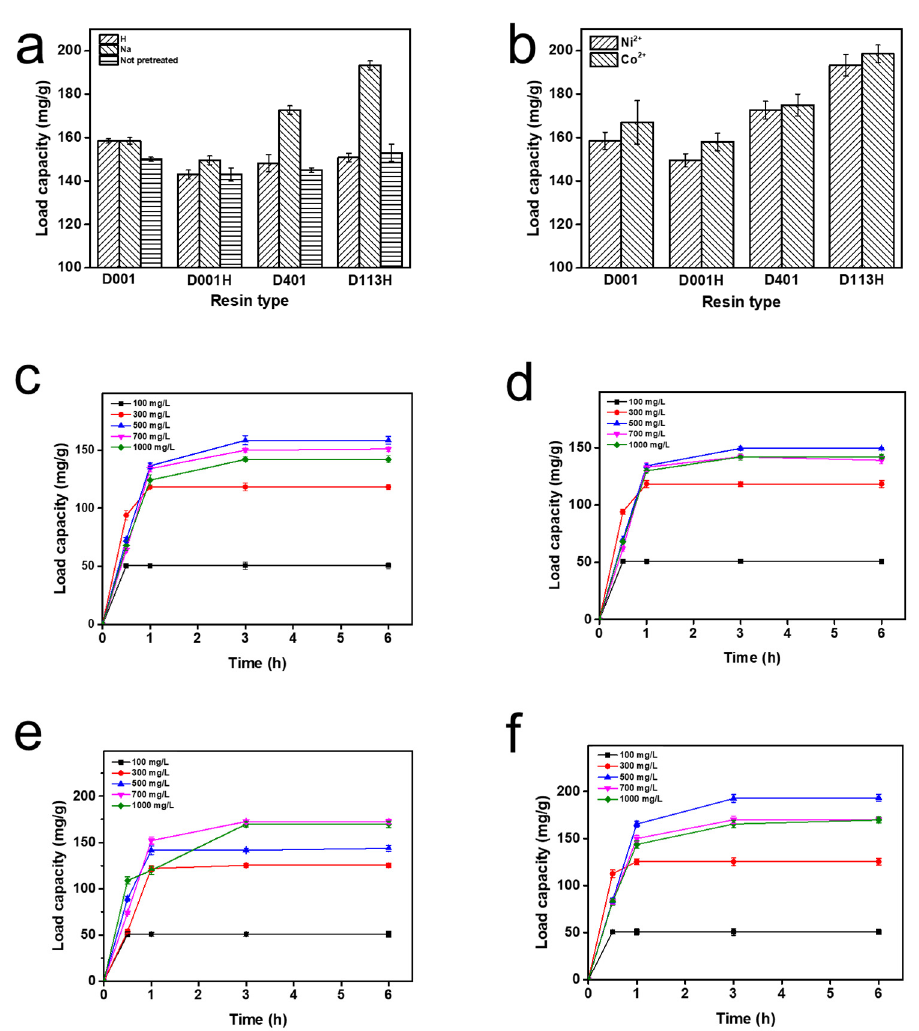
Figure 1. ( a ) Load capacity (mg/g) of resins with different pretreatment methods; ( b ) load capacity (mg/g) of resins with different ions; load capacity (mg/g) of ( c ) D001, ( d ) D001H, ( e ) D401, and ( f ) D113H at different times and ion